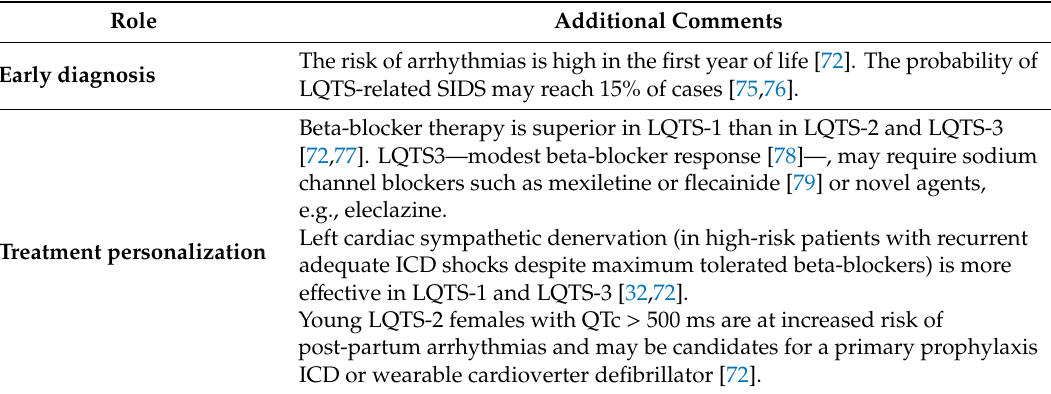
Table 4. Role of genetic testing in